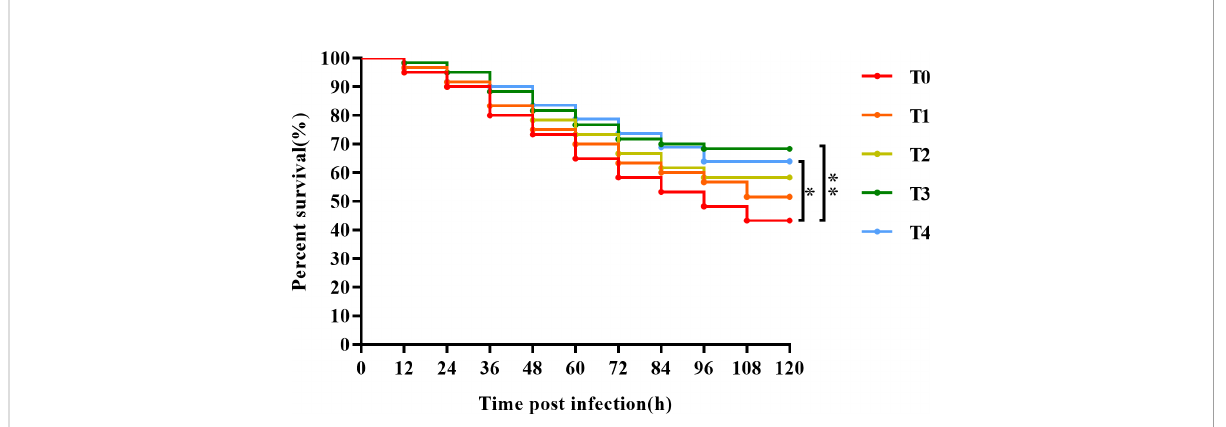
FIGURE 9 The Kaplan-Meier survival analysis of T. ovatus after S. agalactiae infection. Asterisks *, and ** indicate statistically signi fi cant difference between treated group and control group at P < 0.05, and P < 0.01,